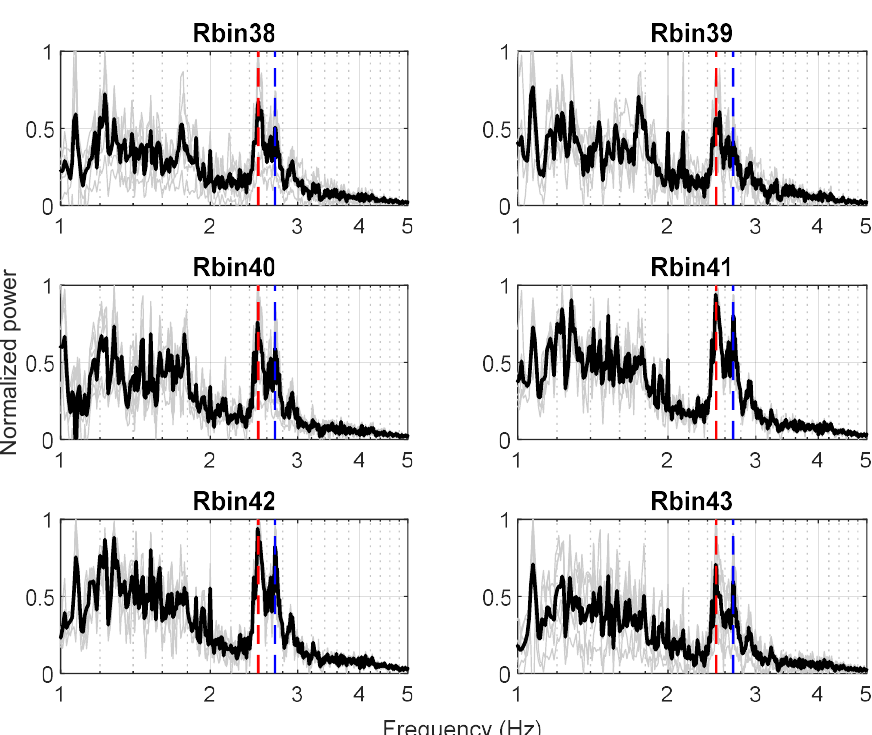
Figure 15. The CPSDs (grey lines) of the combination between the selected Rbin and the rest of the Rbins and the mean CPSD (black). The frequencies 2.49 and 2.79 Hz are indicated with red and blue dashed lines, respectively.